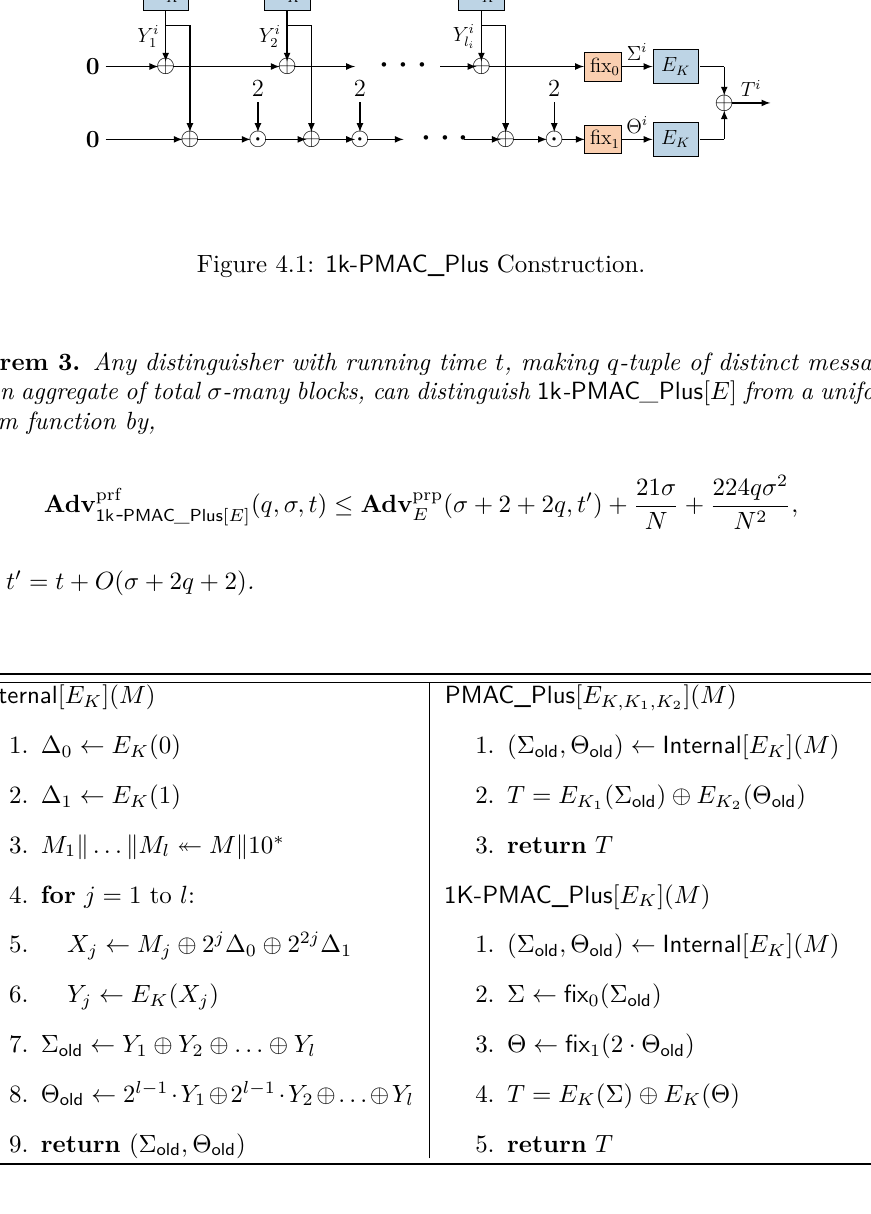
Figure 4.2: 1K-PMAC_Plus Construction; M k 10 ∗ denotes that 10 ∗ string is padded to M to make the size (in number of bits) of the total message multiple of n . M 1 k . . . k M l (cid:17) M k 10 ∗ denotes M k 10 ∗ is partitioned into l -many blocks each of length n bits where n is the block length of the underlying block